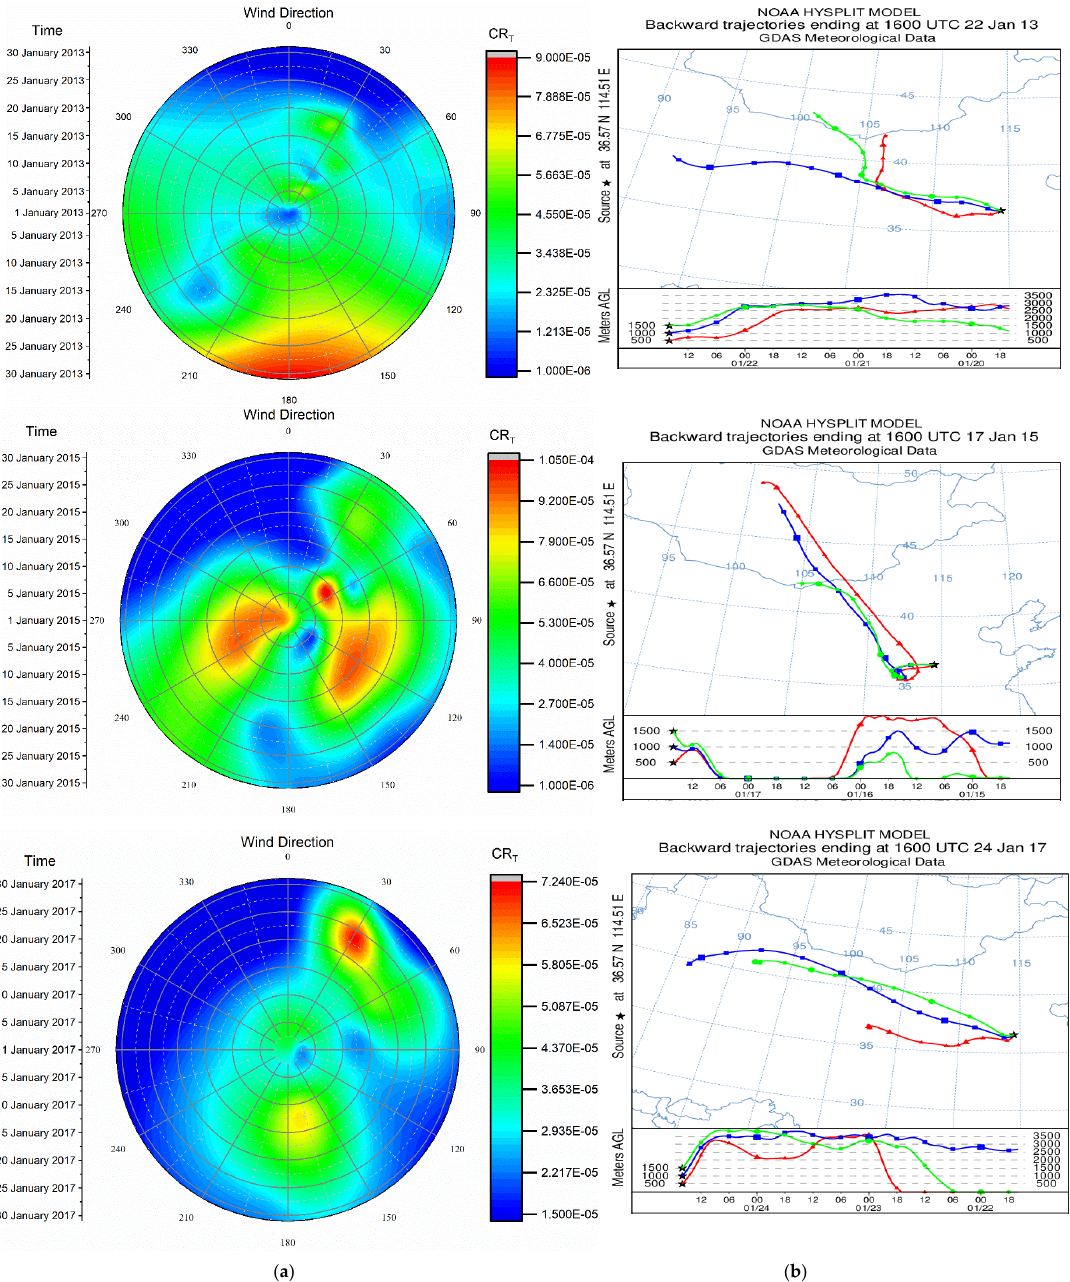
Figure 9. ( a ) Distribution of CR T in wind direction diagram in January; ( b ) 72 h back trajectories on 22 January 2013, 17 January 2015 and 24 January 2017 of Handan.